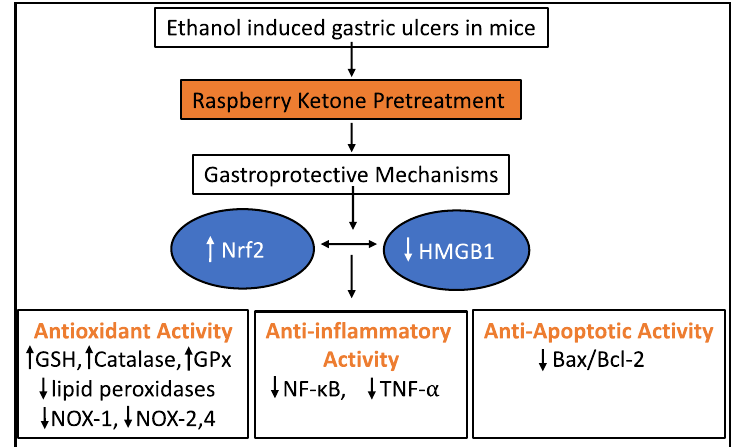
Figure 4. Schematic diagram of the different molecular targets involved in the gastroprotective effects of RK against ethanol-induced gastric ulcer in rats.